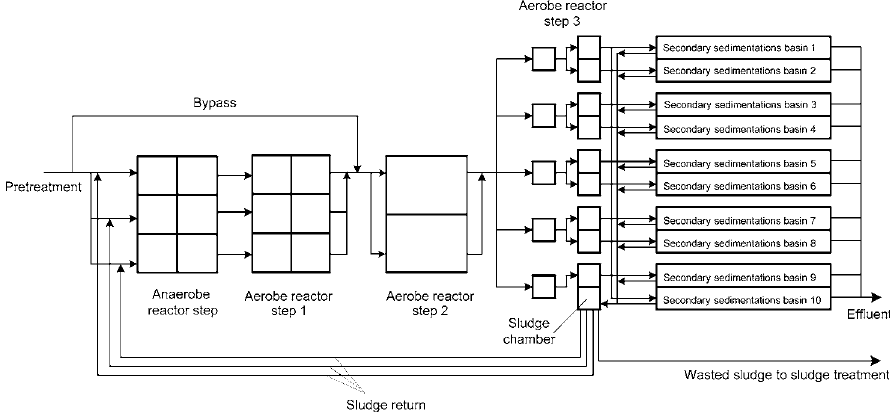
Figure 1. Flowsheet of the Duvbacken Waste Water Treatment